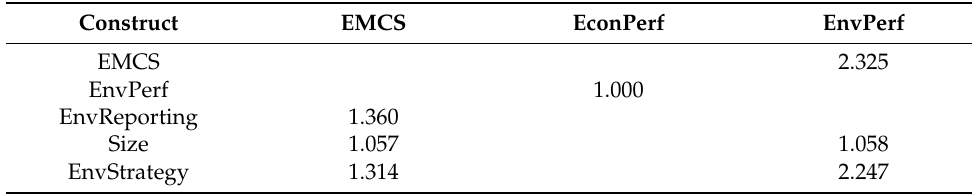
Table 5. Collinearity statistics (variance inflation factor,